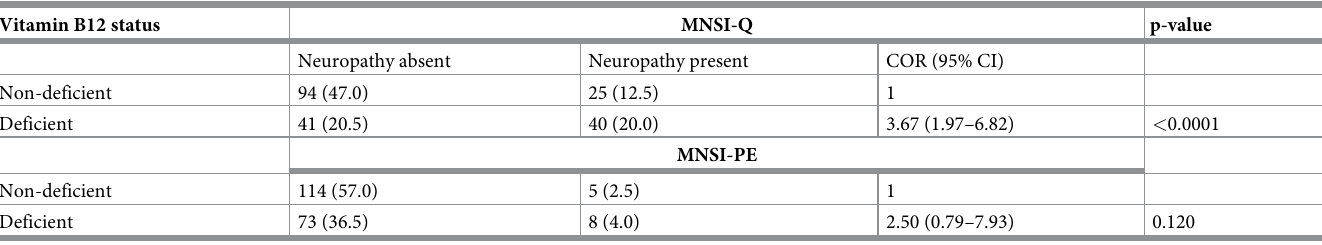
Table 2. Association between vitamin B12 status and diabetic neuropathy. Vitamin B12 status